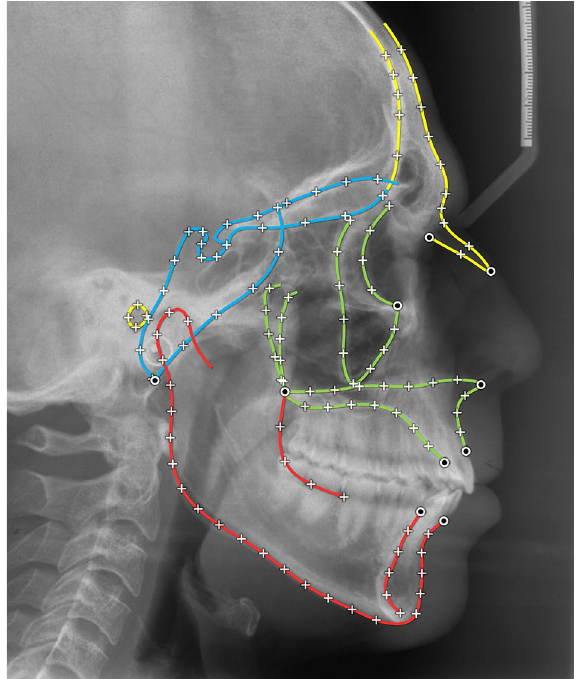
Figure 2. The digitized curves and landmarks. Circles: fixed landmarks; crosses: sliding semilandmarks, initially placed at equidistant positions, then allowed to slide. Blue: cranial base structures (CrB); green: maxillary structures (Mx); red: mandible (Mnd).